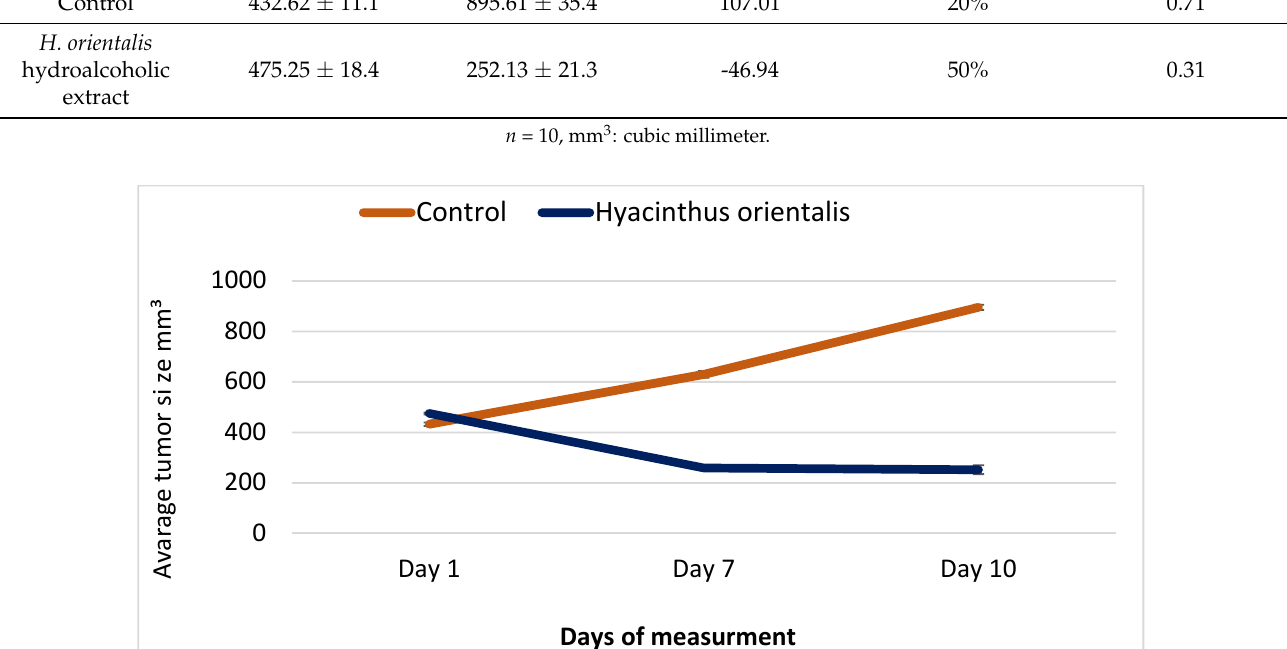
Table 6. Effect of H. orientalis L. hydroalcoholic extract on tumor size and cure percentage. Treatment Groups